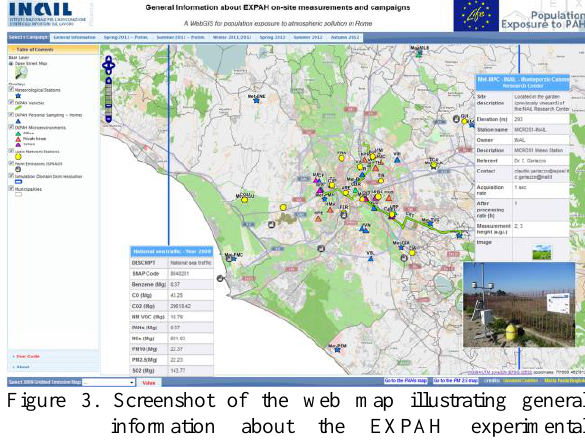
Figure 3. Screenshot of the web map illustrating general information about the EXPAH experimental